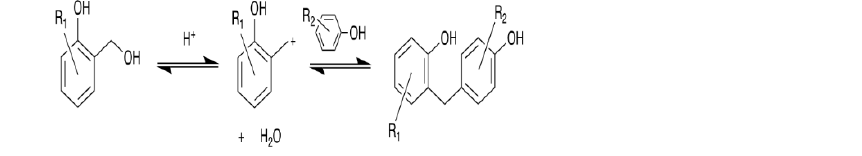
Figure 1. Scheme for the formation of polyphenolic resins.